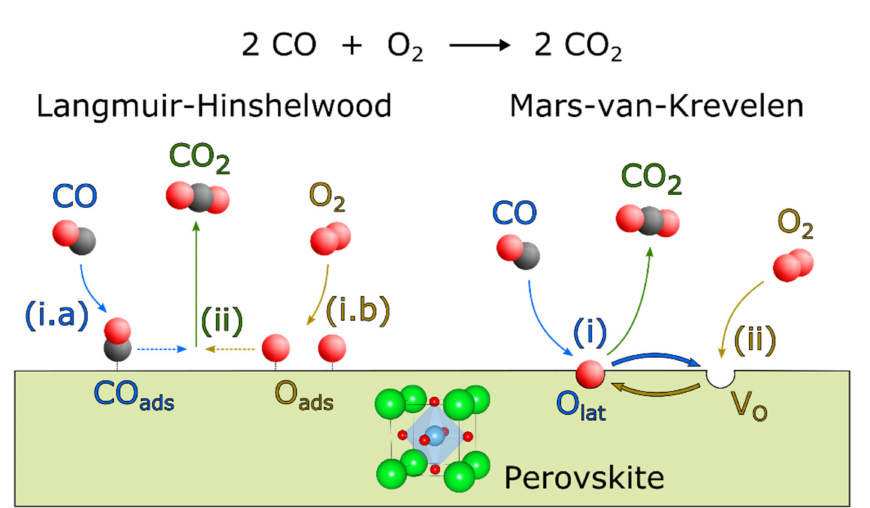
Figure 9. Schematic representation of CO oxidation on a perovskite surface (ideal cubic unit cell shown in the middle). During a Langmuir—Hinshelwood mechanism (left) both reactants adsorb (i.a and i.b, CO ads and O ads , respectively), diffuse along the surface (ii), and form CO 2 , which desorbs. The Mars-van-Krevelen (MvK, right) mechanism proceeds via two steps: (i) CO adsorbs first, reacts with lattice oxygen (O lat ), and desorbs as CO 2 leaving an oxygen vacancy (V O ) behind. (ii) An oxygen molecule from the gas atmosphere adsorbs, splits, and re-fills the